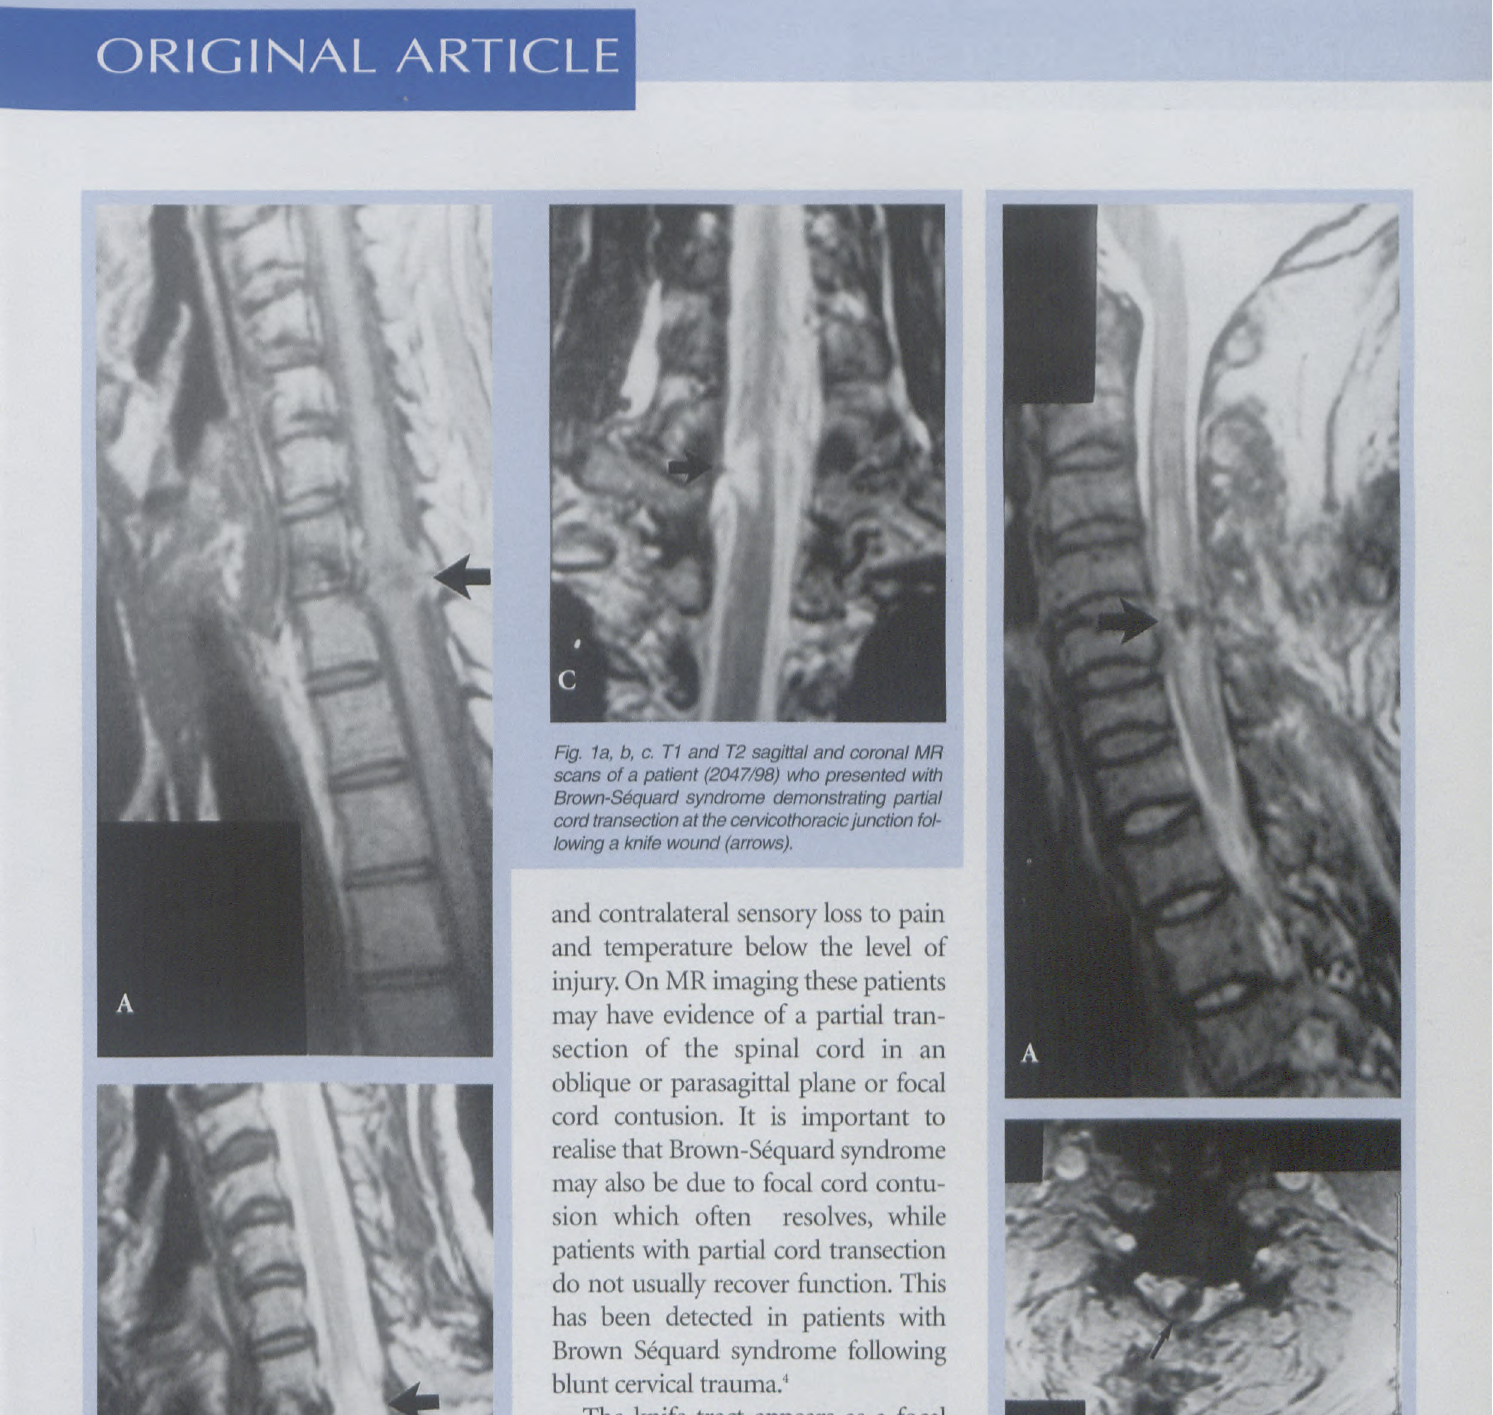
Fig. 2a, b. T2 sagittal and gradient recalled axial MR of a patient who sustained a knife injury to the cervical spine 2 weeks prior to the study. MR demonstrates knife tract, haematomyelia (haemosiderin staining) and hemisection of the cord